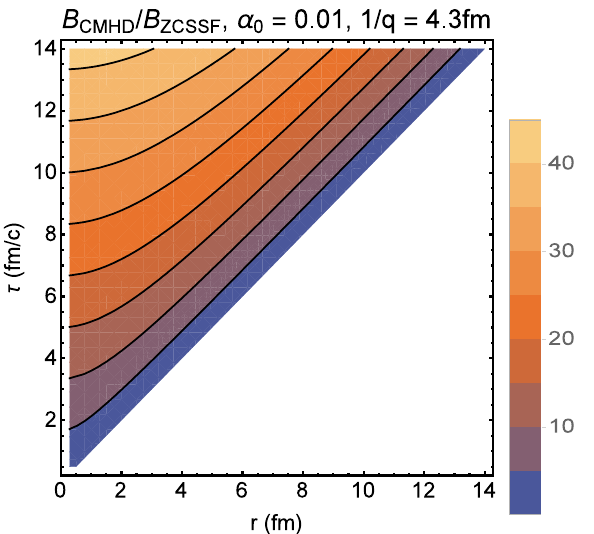
Figure 2 . (color online). The ( τ, r ) dependence of the ratio B ZCSSF /B ZCSSF is plotted for α 0 = 0 . 01 and 1 /q = 4 . 3 fm. Both magnetic fields are comparable around τ = r line. For τ > r and any fixed value of r , the CMHD solution becomes significantly larger than the ZCSSF one.